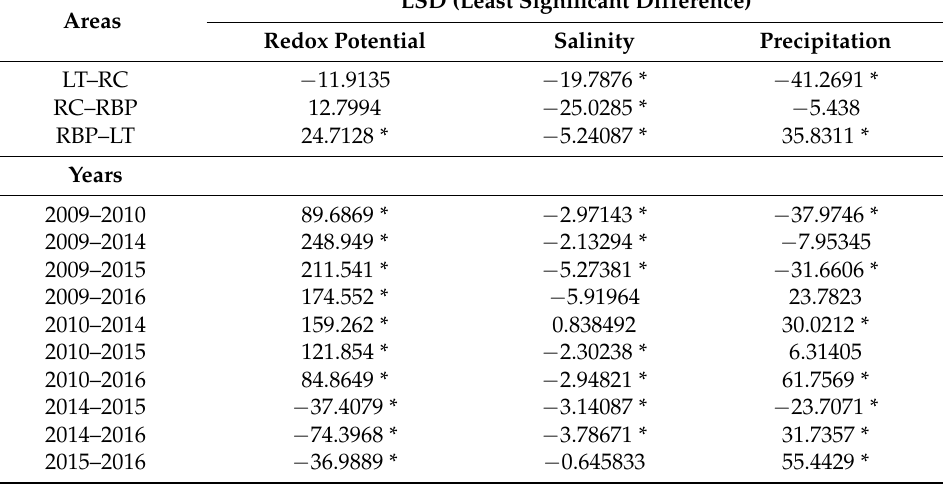
Table 4. Comparison of the Fisher’s Least Significant Difference post hoc tests conducted for the nested ANOVA on potential redox, salinity, and precipitation in terms of area and year. LT: Laguna Terminos; RC: Rio Champoton; RBP: Los Petenes Biosphere